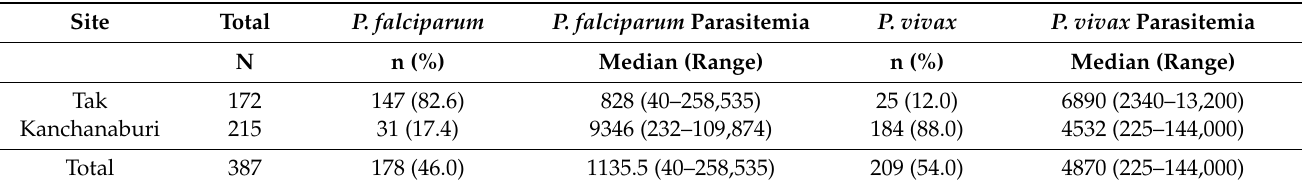
Table 2. Demographic data of samples collected for genetic analysis. Data are presented as number (%) or median (range) value.